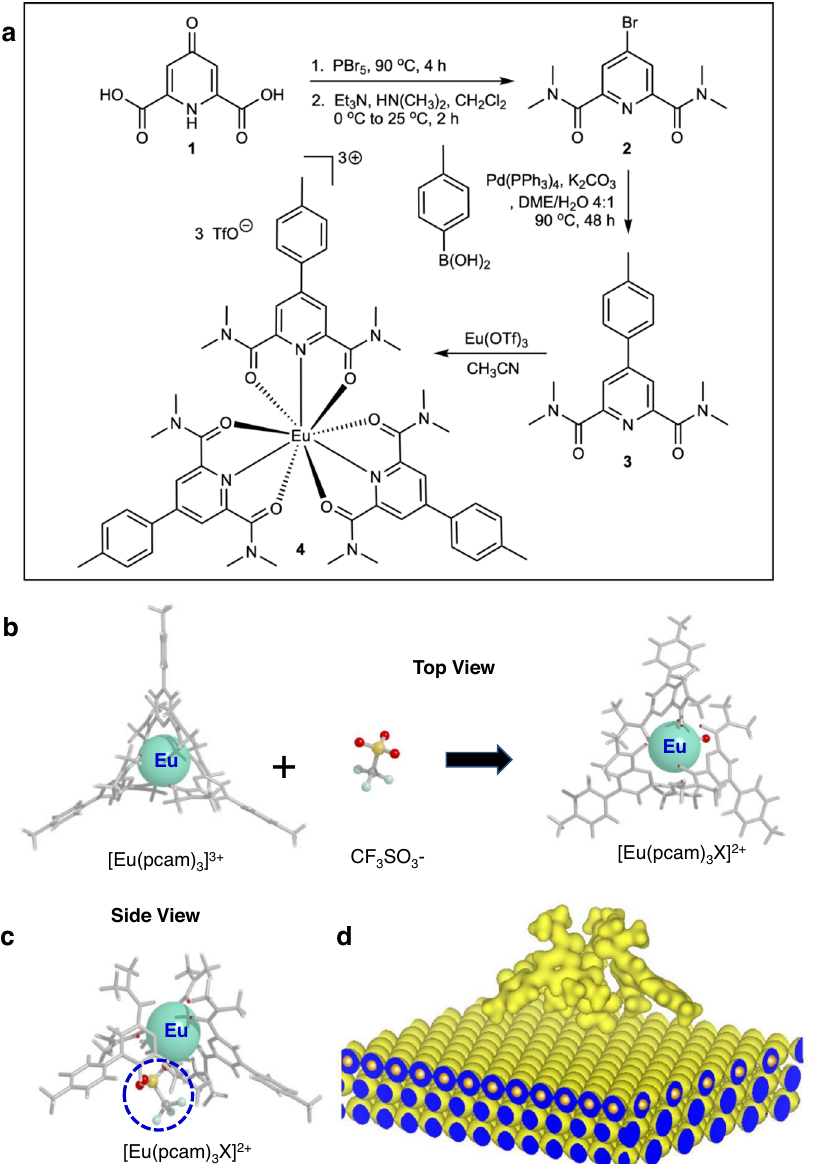
Fig. 1 | Structure of rare-earth coordination complexes. a Synthetic route of pcam( 3 )and[Eu(pcam) 3 ](CF 3 SO 3 ) 3 . b Topviewsof[Eu(pcam) 3 ] 3+ ,thetri fl ateanion and complex [Eu(pcam) 3 X] 2+ . c Side view of complex [Eu(pcam) 3 X] 2+ with the